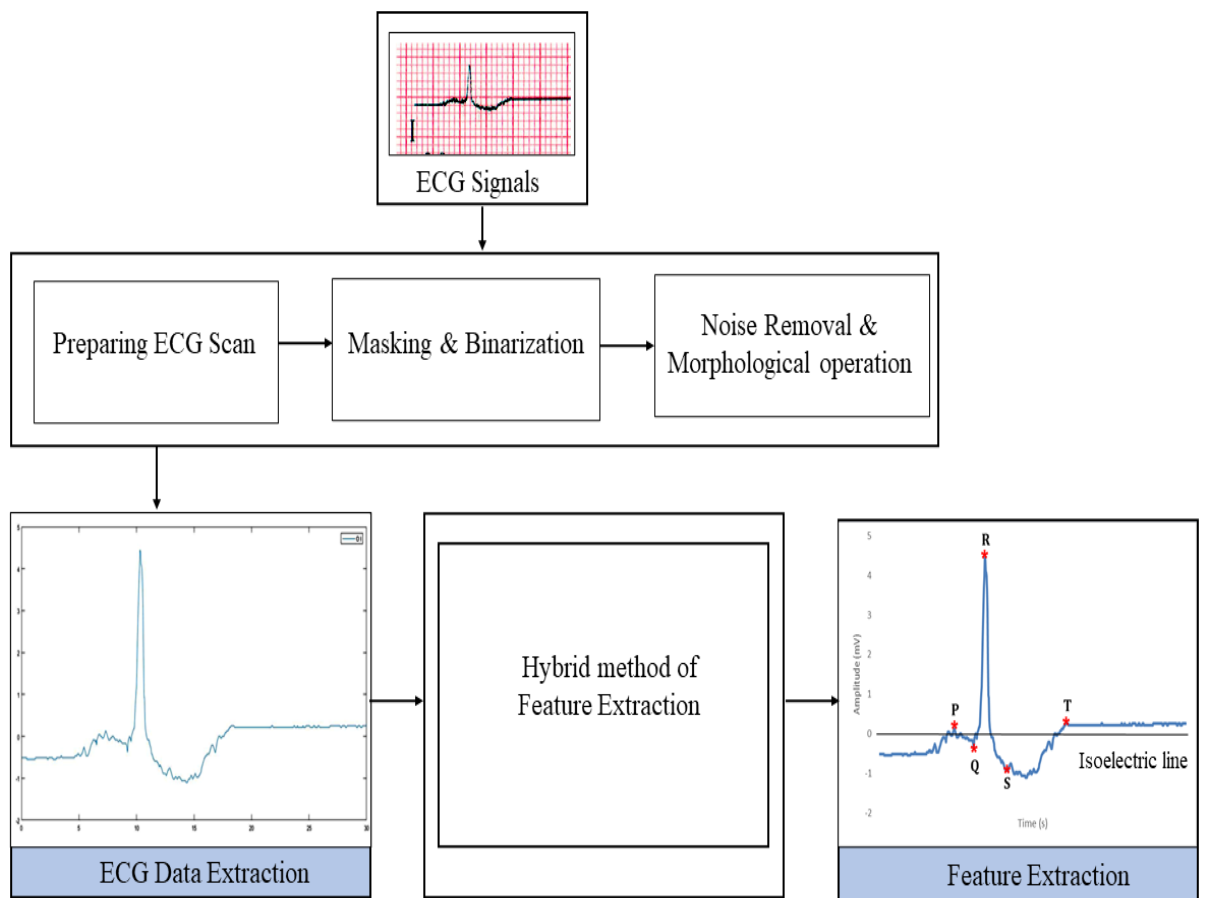
Figure 3. Twelve-lead TMT-ECG digitization methodology.